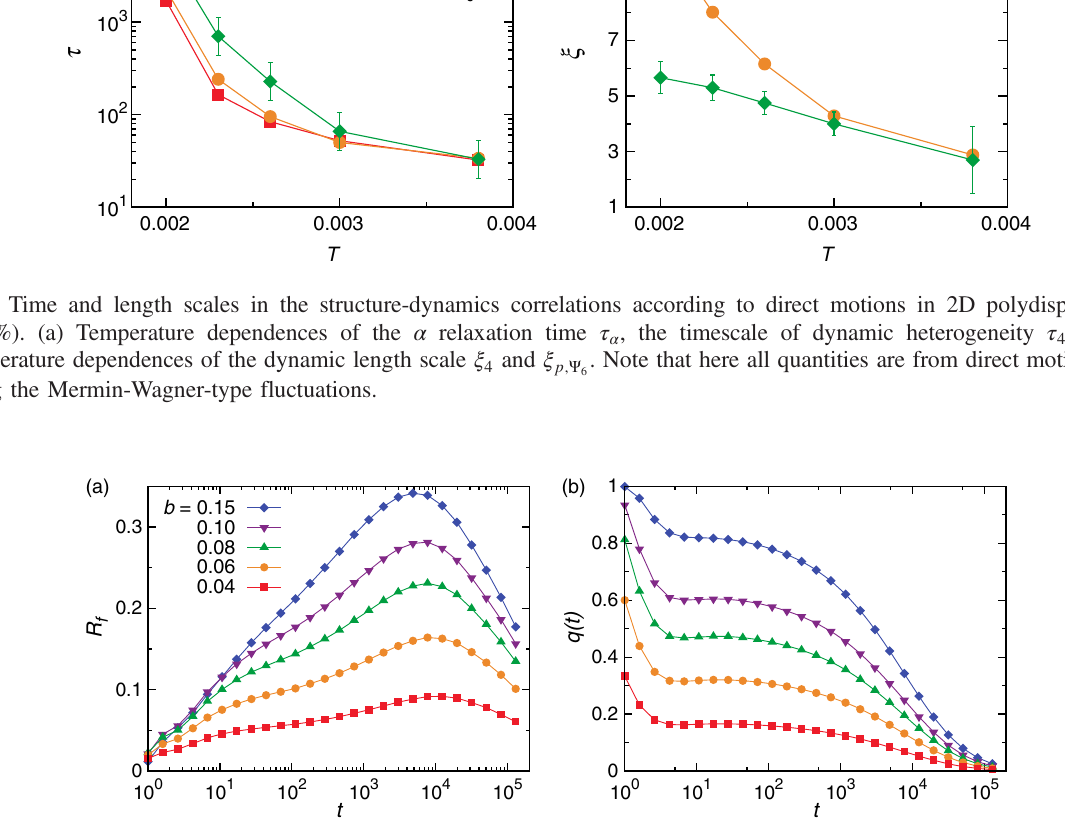
FIG. 10. Signatures of fast β dynamics for 2D polydisperse system ( Δ ¼ 11% ) at T ¼ 0 . 002 . (a) The relative contribution from the structure to the overall dynamic fluctuations R probed at different cutoff length b . (b) Overlap function q ð t Þ according to different cutoff f length b for the same system as